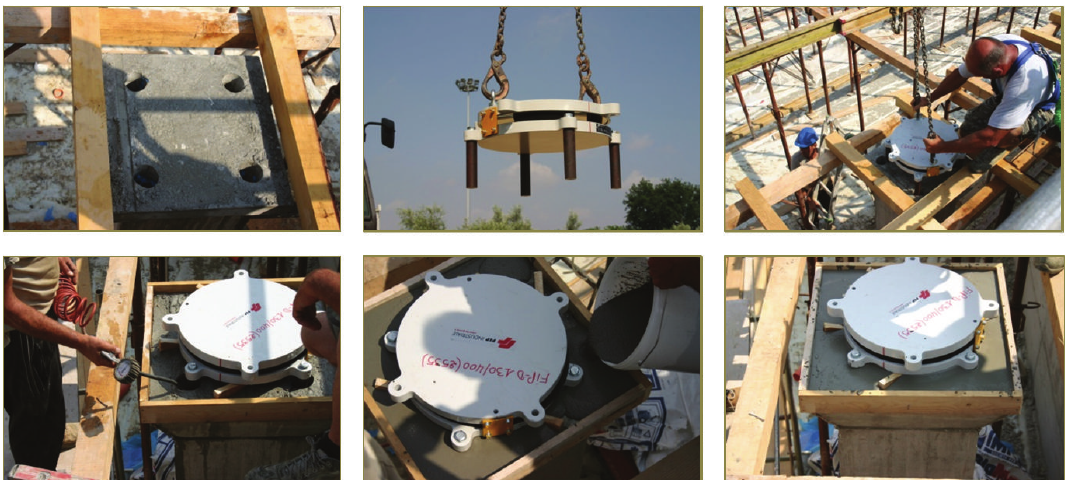
Figure 14: Images of the installation works of a DFP isolator over a